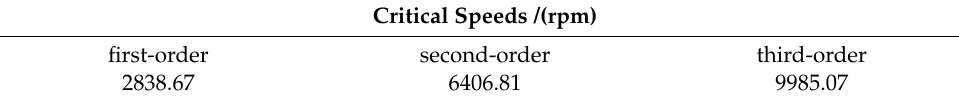
Table 2. Calculated value of the first three critical speeds of high − speed flexible rotors.